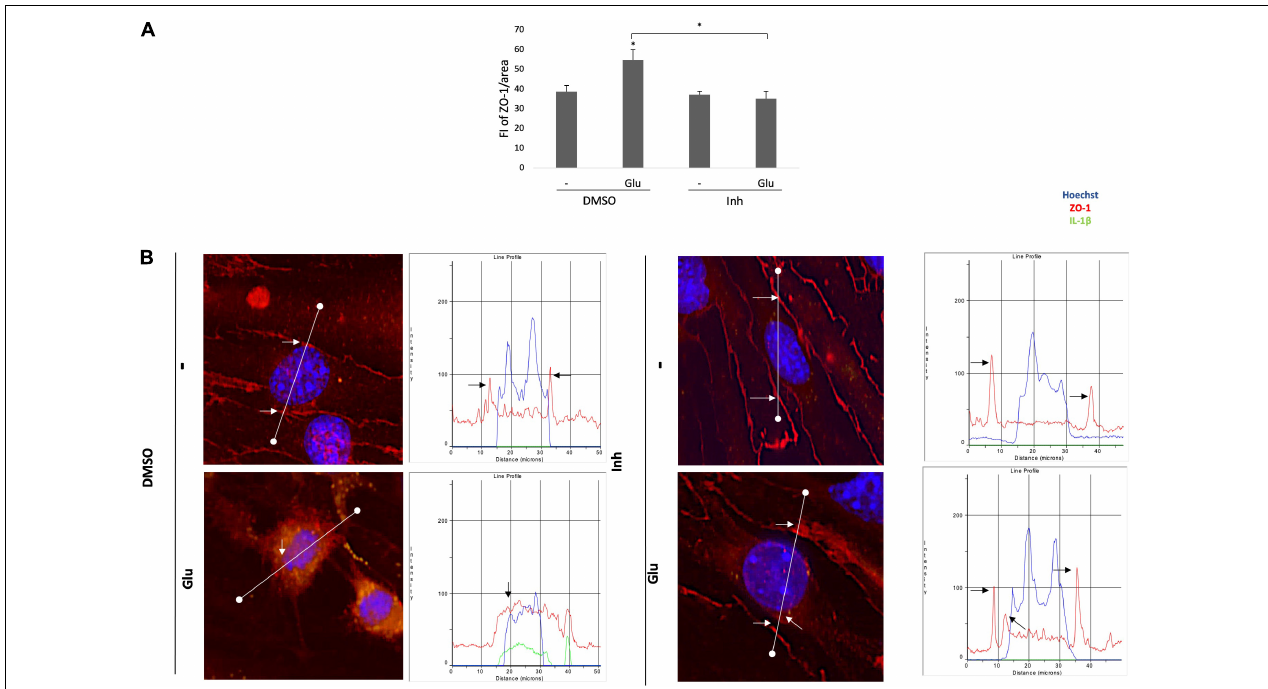
FIGURE 8 | BACE1-inhibited astrocytes reversed the increased IR and cytoplasmic distribution of the ZO-1 protein caused by glutamate in ECs. (A) FI of ZO-1 per unit area, quantified from 20 cells per treatment for each n ( n = 4 performed in duplicate) and divided by unit area. The data are presented as the means ± SEM. ANOVA followed by Tukey’s test. * P < 0.05. (B) Fluorescence profiles (right column) showing the cellular distributions of ZO-1 (red line) in relation to the nucleus (blue line) and IL-1 β (green line) based on the representative images (left column). The black arrows indicate the tight junction peaks to show the changes in ZO-1 distribution by the treatment. The white line drawn on each cell represents a distance of 50 µ m. DMSO = vehicle, Inh = β -secretase inhibitor IV, - or Glu refers to glutamate